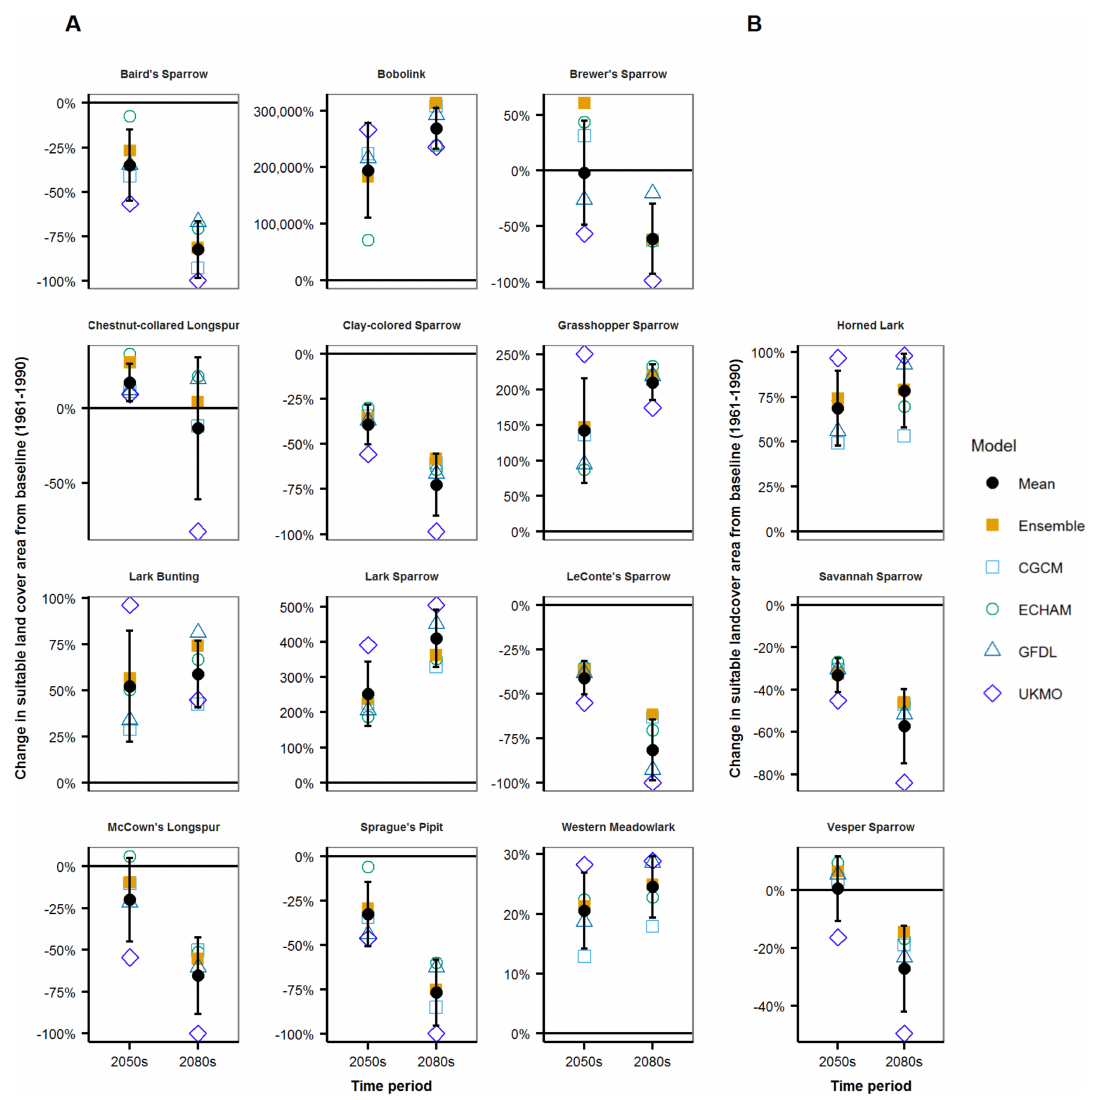
Fig. 4 . Projected change in area of currently suitable land cover within suitable climate from the historical baseline (1961–1990) for two future time periods in Alberta, Canada. The mean change (± 95% CI) was determined from the four unique global climate models. Symbols as in Fig. 2. Species are separated according to use of land cover types for breeding: (A) 12 species that use both native and tame pasture and hayland, and (B) three species that additionally use cropland (Table 1). Note the difference in scales between